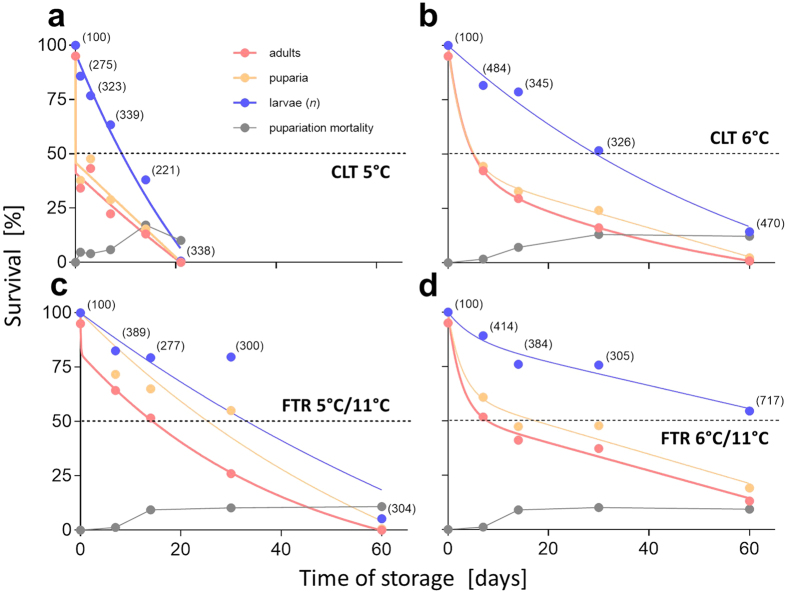
Survival under selected CLT and FTR regimes.(a–d) Survival of quiescent larvae of Drosophila melanogaster stored at two constant low temperatures (CLTs) of 5 °C (a) and 6 °C (b), and two fluctuating thermal regimes (FTRs) of 5 °C/11 °C (c) and 6 °C/11 °C (d).Three different levels of survival were scored: live larvae (blue circles, larvae showing spontaneous movements); puparia (orange circles, formation of morphologically normal puparium); and adults (red circles, eclosion of morphologically normal adult). In addition, we counted numbers of malformed puparia on the wall of the glass tube (grey circles) and scored them as ‘pupariation mortality.’ Numbers within parentheses are the total number of all individuals (n, including dead larvae) recovered at each time. The two-phase exponential decay curves (Prism 6.0, GraphPad, San Diego, CA, USA) were fit to survival data with a goodness of fit, R2: (a) 0.9778, larvae; 0.9800, puparia; 0.9795, adults; (b) 0.9871, larvae; 0.9940, puparia; 0.9952, adults; (c) 0.8406, larvae; 0.9219, puparia; 0.951, adults; (c) 0.9544, larvae; 0.9682, puparia; 0.9863, adults.